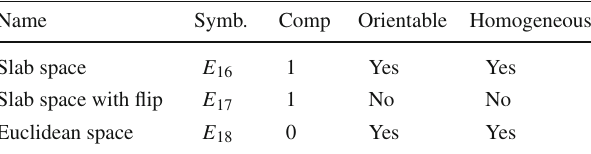
Table 1 Names and symbols of the simply-connected E 3 = E 18 , and two multiply-connected flat orientable and non-orientable Euclidean quotient manifolds M 3 = E 3 /Γ along with the number of compact dimensions (Comp.), orientability and global (topological) homogene- ity Name